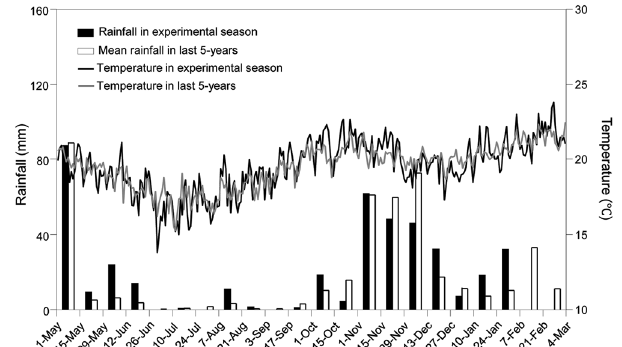
Figure 1. Biweekly precipitation distributions and daily mean air temperature in the experimental seasons and last 5 years (2009 ‒ 2013) in KARI-Katumani Centre, Kenya.